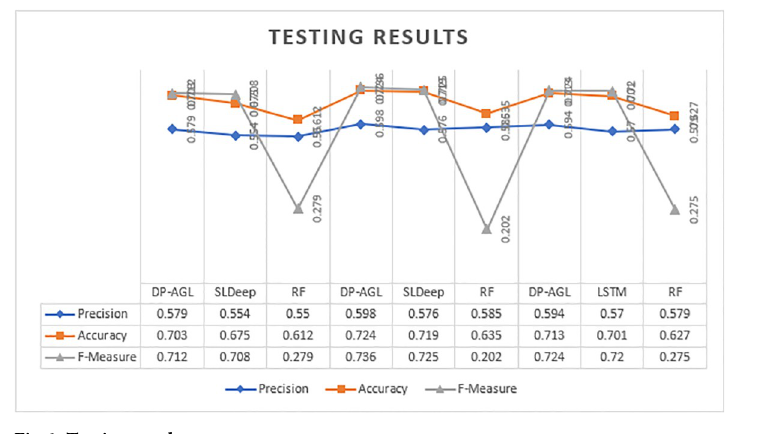
Fig 6. Testing result.